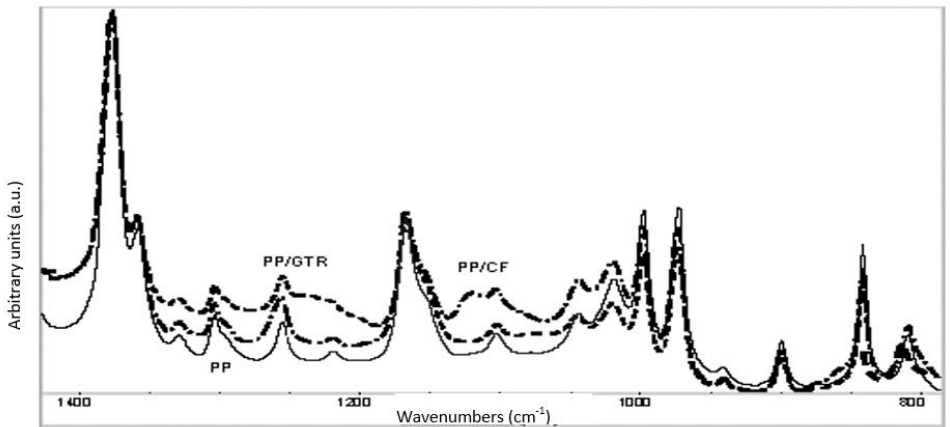
Figure 7. FTIR spectra of PP matrix and composites PP/GTR20 and PP/CFs20.